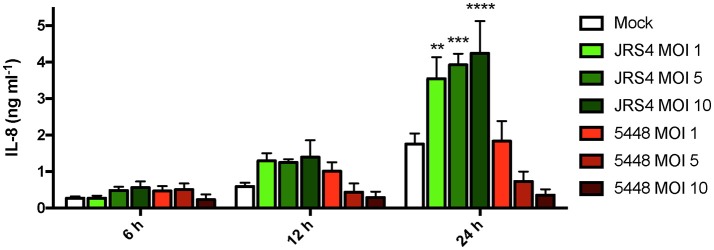
5448-infected TEpi cells show reduced levels of IL-8 detected. IL-8 produced by TEpi cells intracellularly infected with GAS strains 5448 and JRS4, as measured by ELISA. Data are plotted as the mean ± s.e.m. and are combined from three independent experiments performed in triplicate and analyzed by two-way ANOVA with Tukey's post-test. Significance is shown relative to mock at each timepoint. **P < 0.01; ***P < 0.001; ****P < 0.0001.